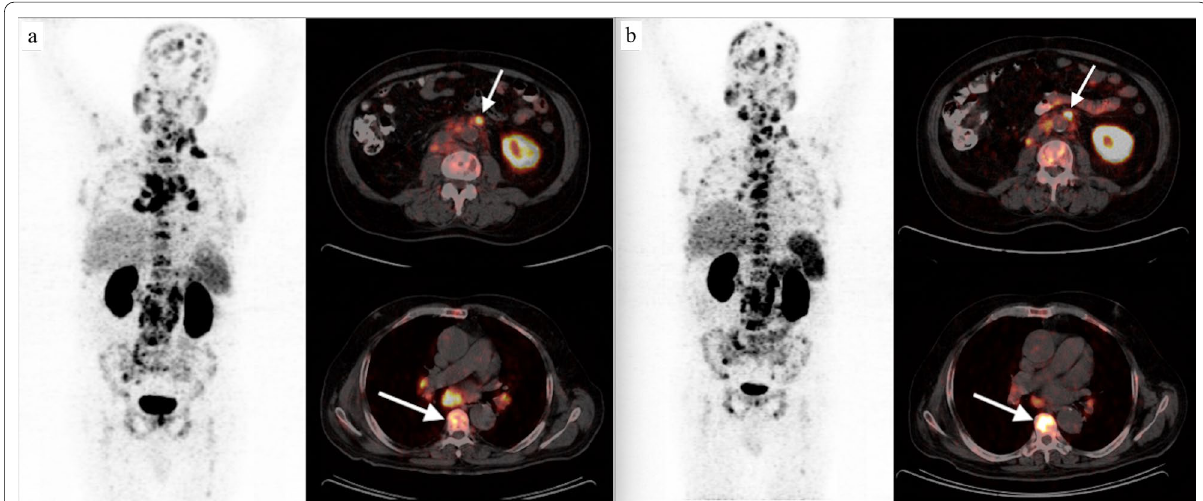
Fig. 2 The [ 68 Ga]Ga-PSMA-11 PET/CT images of a 63 years old patient who received cabazitaxel following goserelin and docetaxel before ( a ) and after ( b) therapy. Despite decreasing of serum PSA from 382 ng/ml to 236 ng/dl and considering the patient in biochemically stable group, new metastatic abdominal paraaortic lymph nodes and bone lesions were detected and [ 68 Ga]Ga-PSMA-11 uptakes of those were increased significantly (arrows)